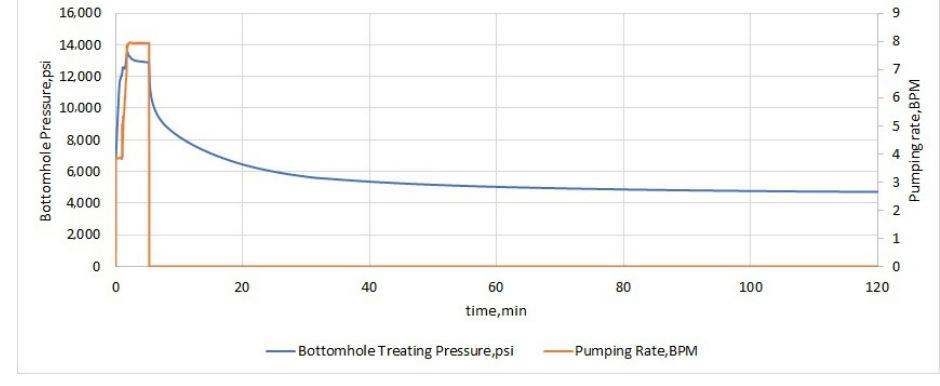
Figure 20. Pumping chart for well X-01.